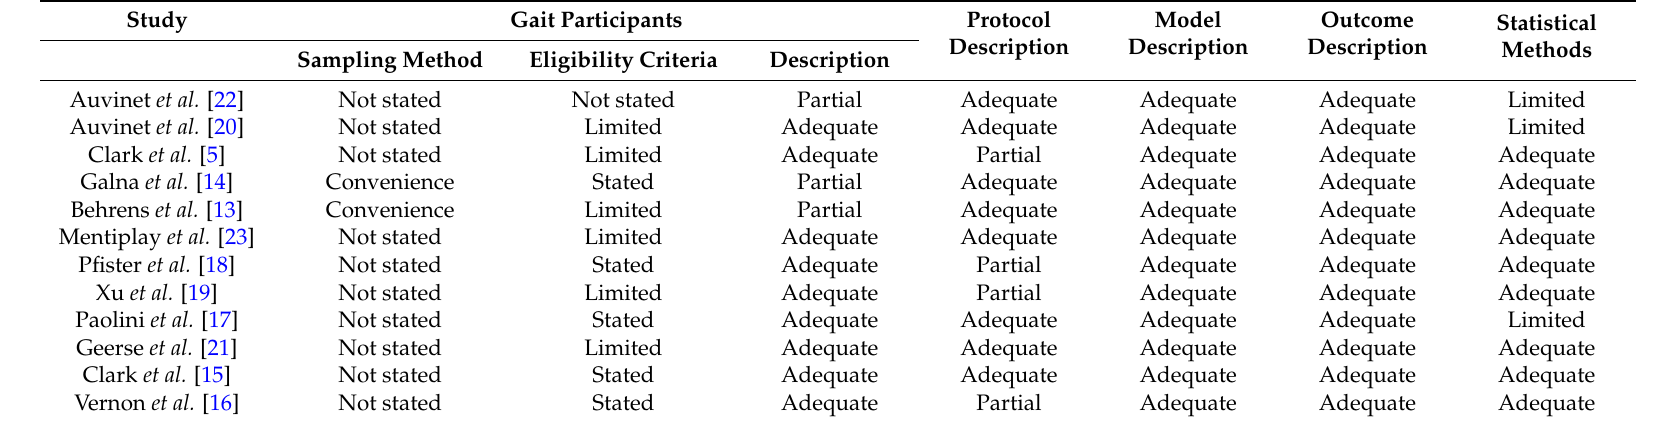
Table 1. Methodological quality of the reviewed articles.